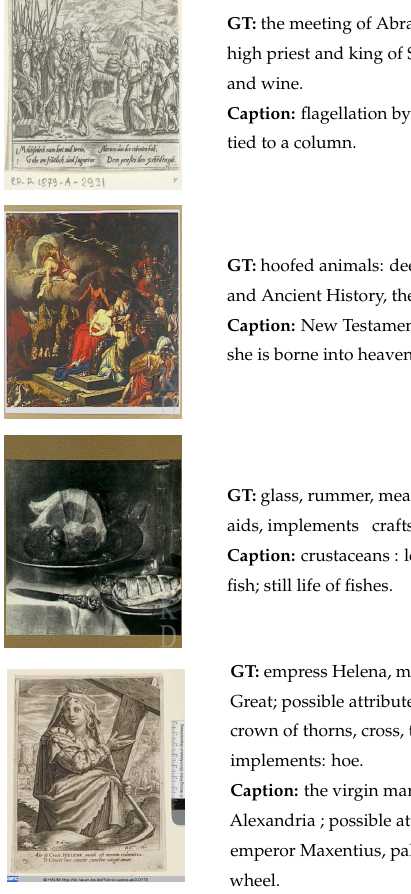
Figure 4. Examples of images from the Iconclass Caption test set, with their corresponding ground-truth and generated captions. Examples shown on the left side represent cases where the generated captions are successfully aligned with the iconographic content of the image, while examples shown on the right demonstrate unsuccessful